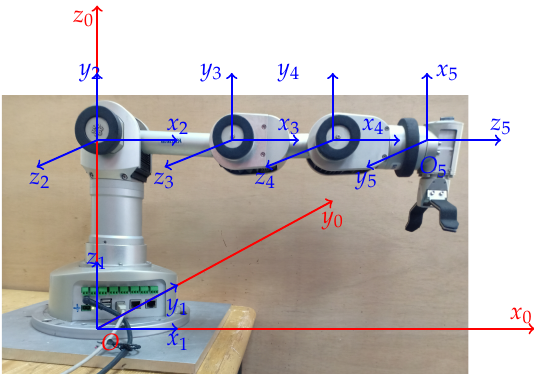
Figure 1. Structure of the 5-DoF robotic